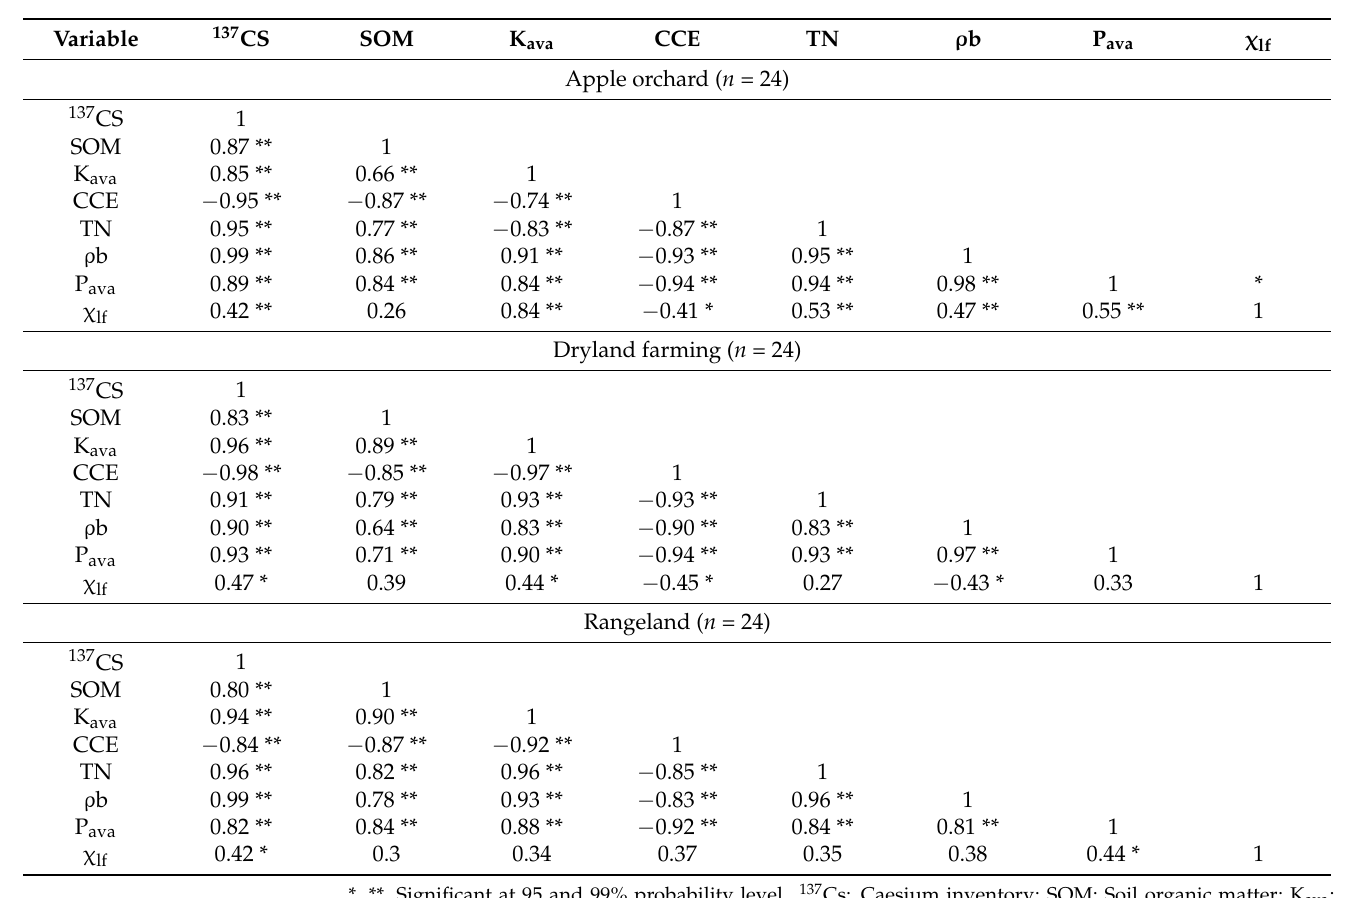
Table 4. Correlation coefficients among the soil properties in the studied sites at different land